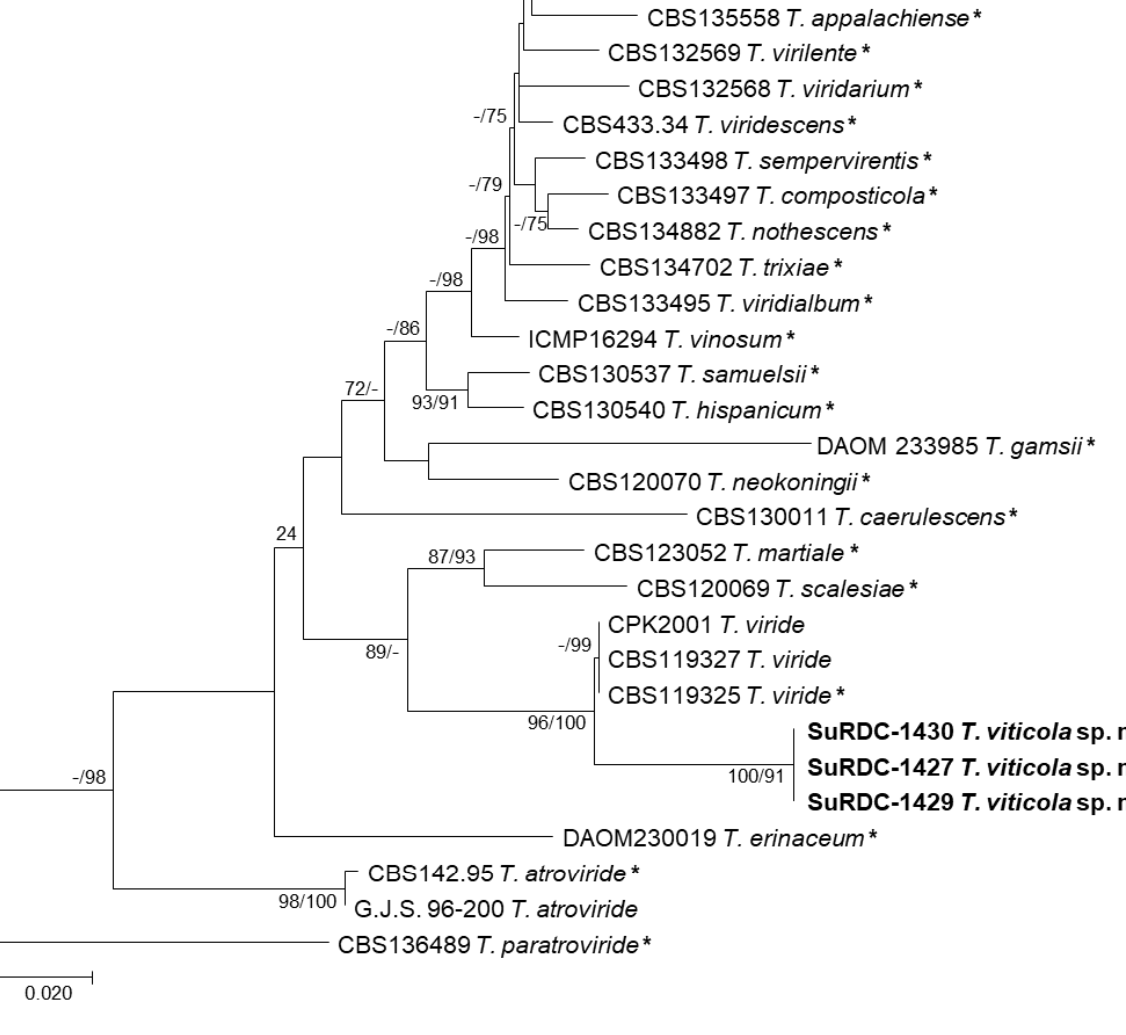
Figure 3. Phylogram of the highest log likelihood tree from analyses of the TEF1 viride / viridescens dataset. Numbers in front of and after the slash represent ML and MP bootstrap values from 1000 replicates, respectively. Values represented by a dash (-) were less than 70% for the bootstrap analyses. Type specimens are indicated with an asterisk and Trichoderma isolates from vineyards in BC are indicated in bold. Bar indicates the number of substitutions per site.